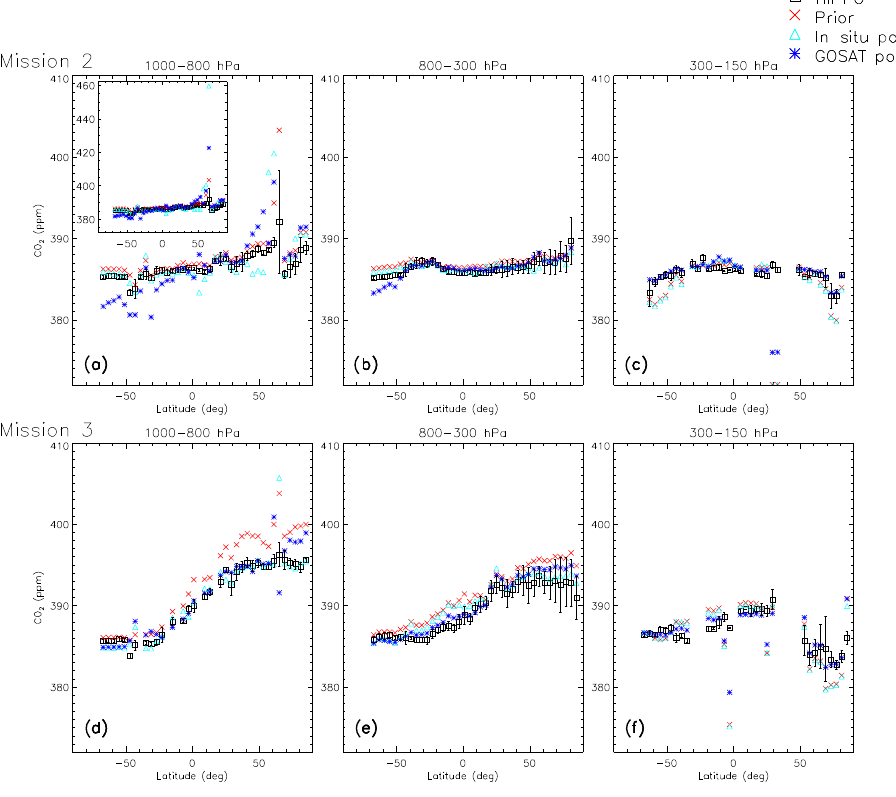
Figure 10. Latitudinal profiles of CO 2 mole fractions for HIPPO observations and co-sampled prior, in situ only posterior, and GOSAT only posterior. Mission 2 (a–c) took place during 31 October–22 November 2009; Mission 3 (d–f) took place 24 March–16 April 2010. Values are averaged in three altitude bins and 4 ◦ latitude bins. The inset in (a) contains an expanded y -axis range that shows two points that do not fit into the default range. Flight segments over the temperate North American continent (east of − 130 ◦ ) are excluded from this comparison in order to focus on the Pacific. Error bars represent the standard deviations of the observations within each